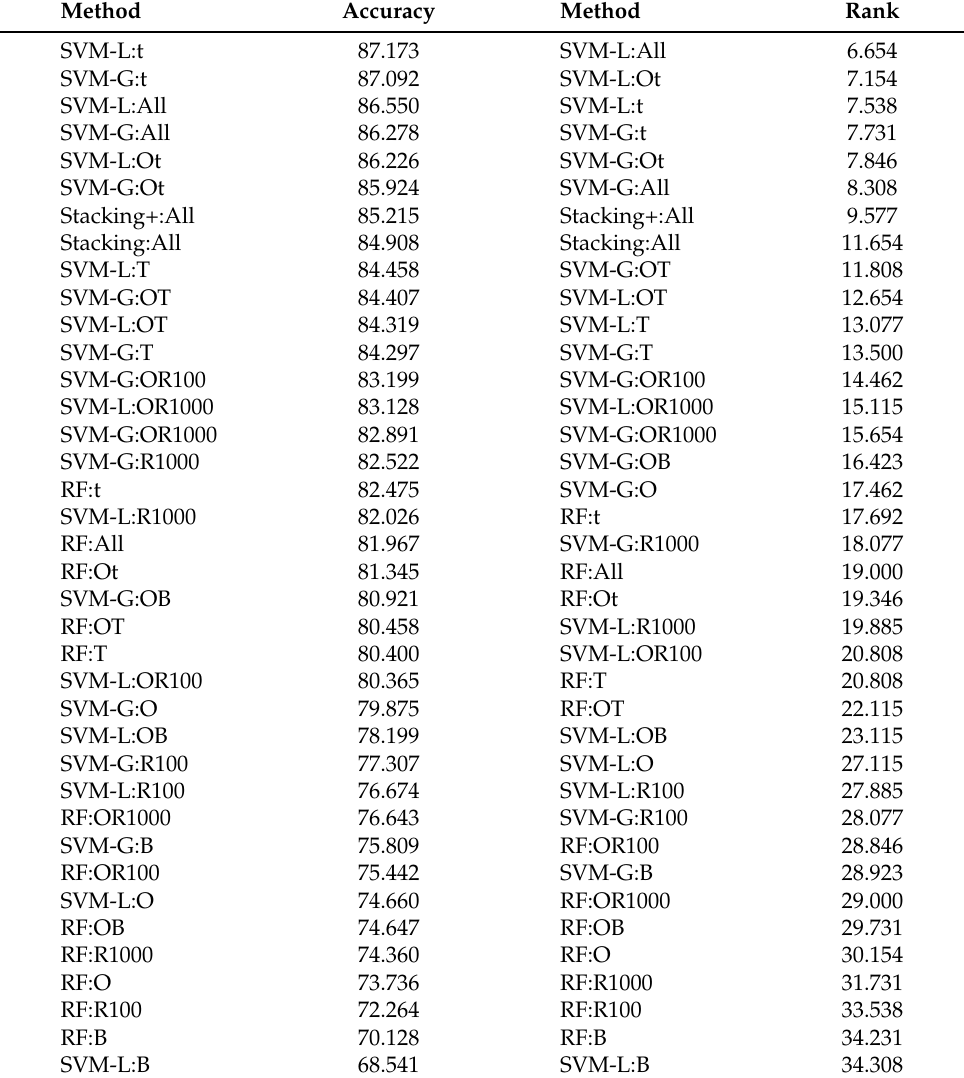
Table 7. Average accuracies and ranks from the difficult datasets .